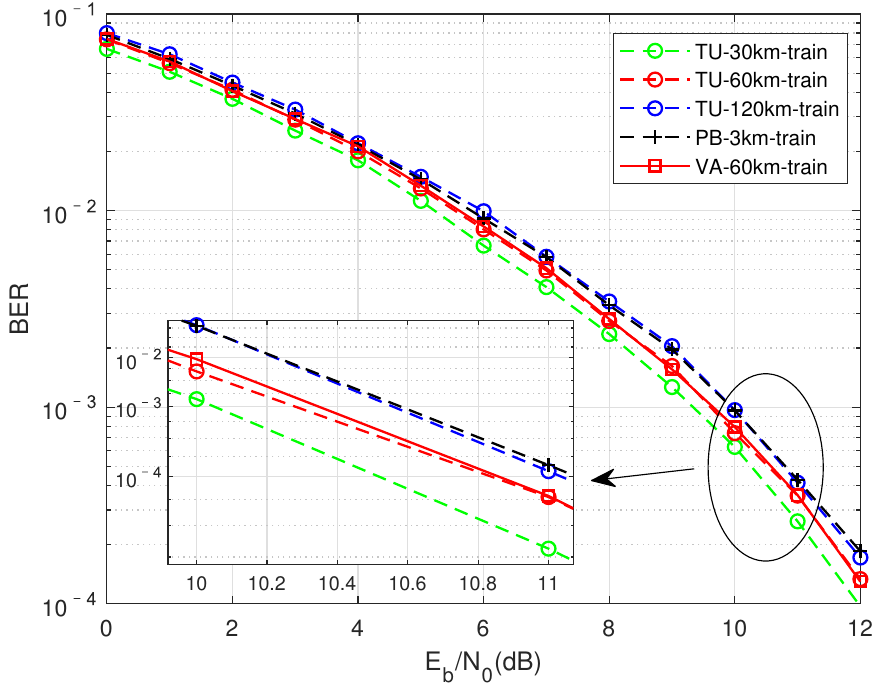
Figure 9. Perform training in different channel environments under the condition of matching signal-to- noise ratio, test with TU-30 km/h, performance under the condition of compression factor τ = 0.7.